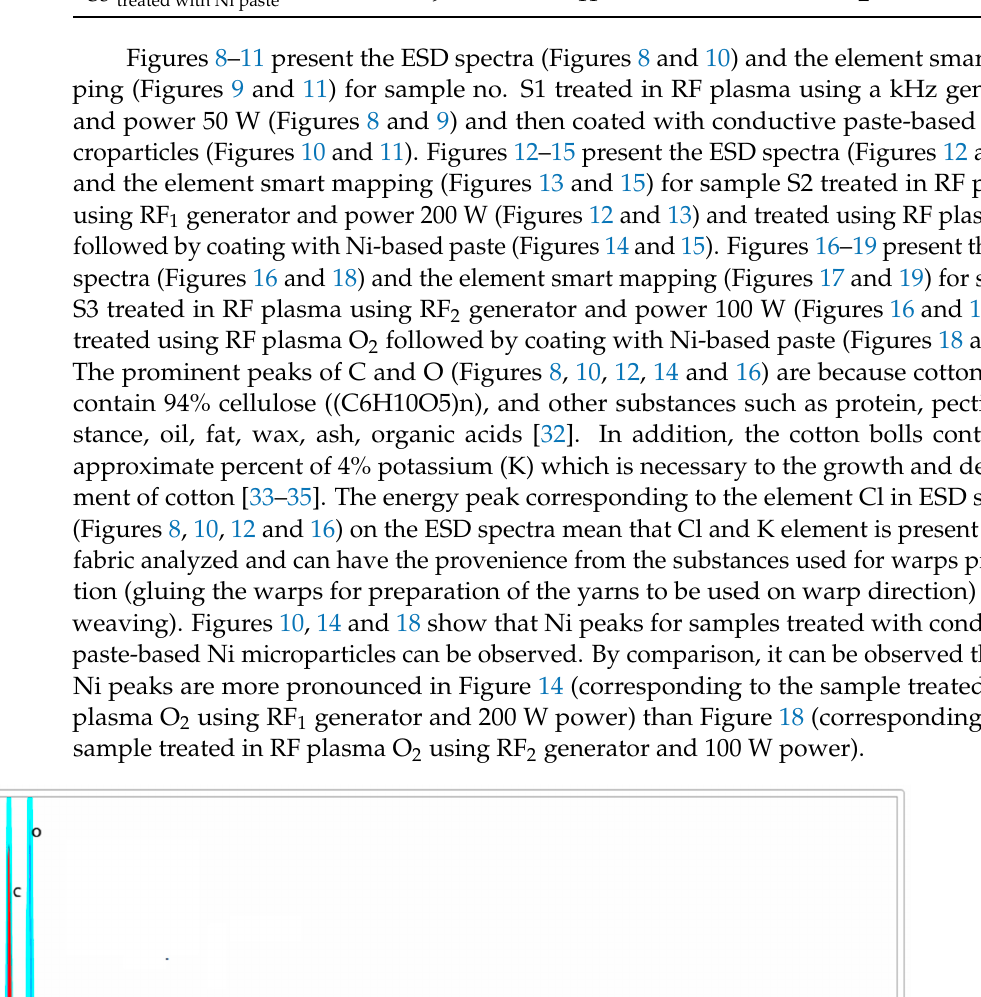
2 , using RF 2 generator and power 50